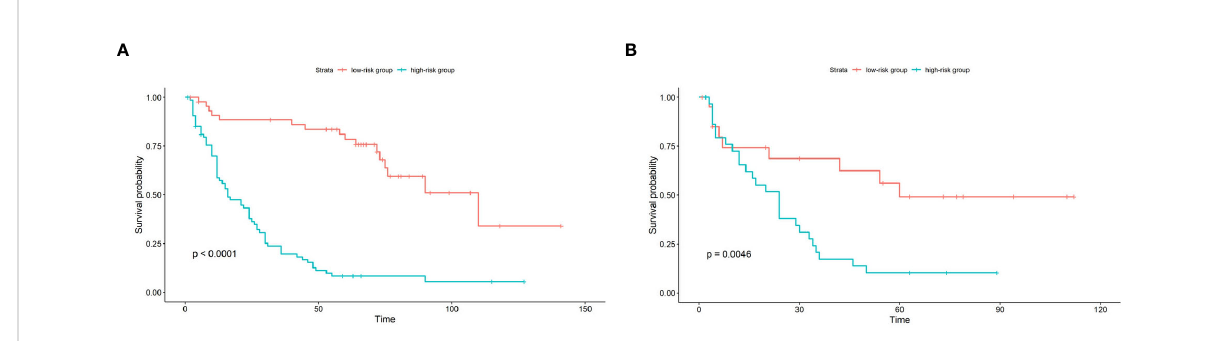
FIGURE 5 Kaplan-Meier survival curve of patients in the train cohort (A) and test cohort (B) strati fi ed by nomogram predicted score. In the low-risk group, the score is lower than the mean score of the group; in the high-risk group, the score is higher than the mean score of the